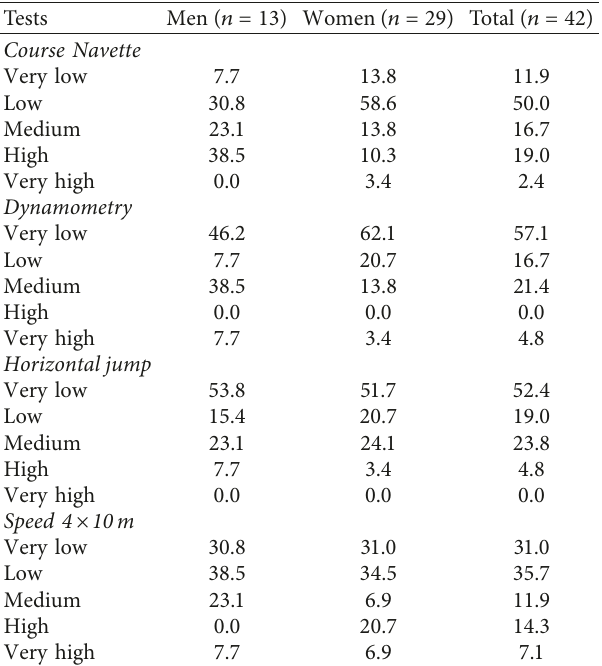
Table 2: Results of physical fitness tests of adolescents (%).